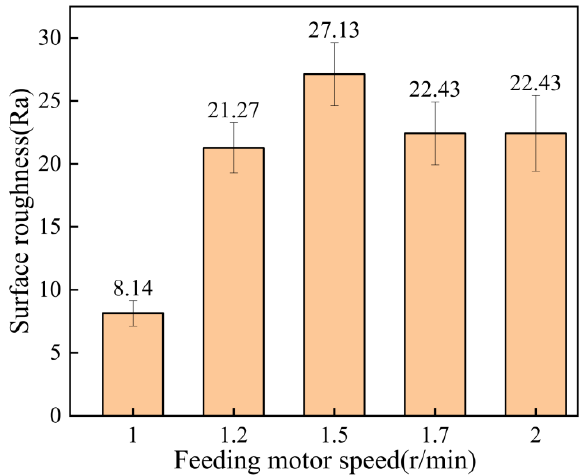
Figure 11. Surface roughness of coating at different feeding motor speeds.